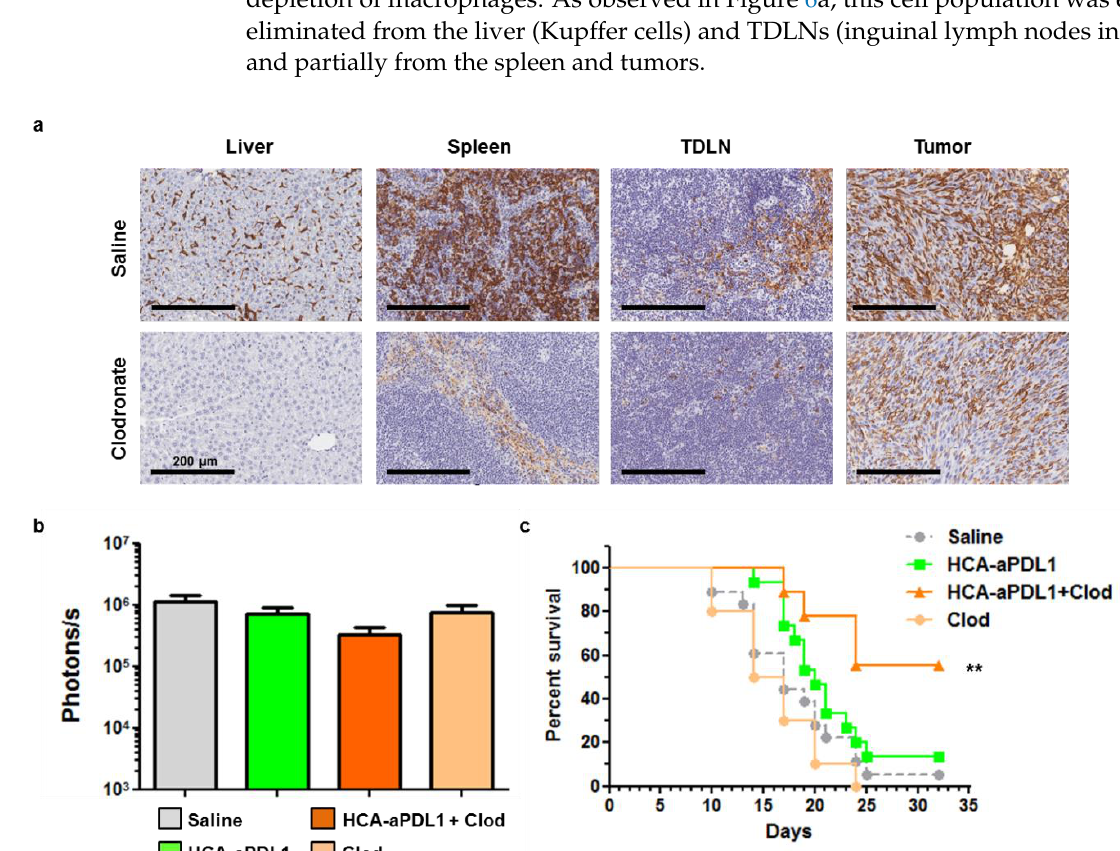
Figure 6. Depletion of macrophages increases the survival of mice treated with HCA-EFZP-aPDL1 in the PC model. Tumors were established and treated with HCA-EFZP-aPDL1 as described in Figure 4. Clodronate-loaded liposomes (0.5 mg clodronate in 100 µL) were administered i.v. on days 1 and 8, alone or in combination with the vector ( n = 9). ( a ) A subset of mice was sacrificed 24 h after clodronate treatment for identification of macrophages in the indicated tissues by im- munohistochemistry. ( b ) Light emission from tumors at day 7. ( c ) Survival curve. ** p < 0.01, log-rank test. Data are repre- sented as average ± SEM.